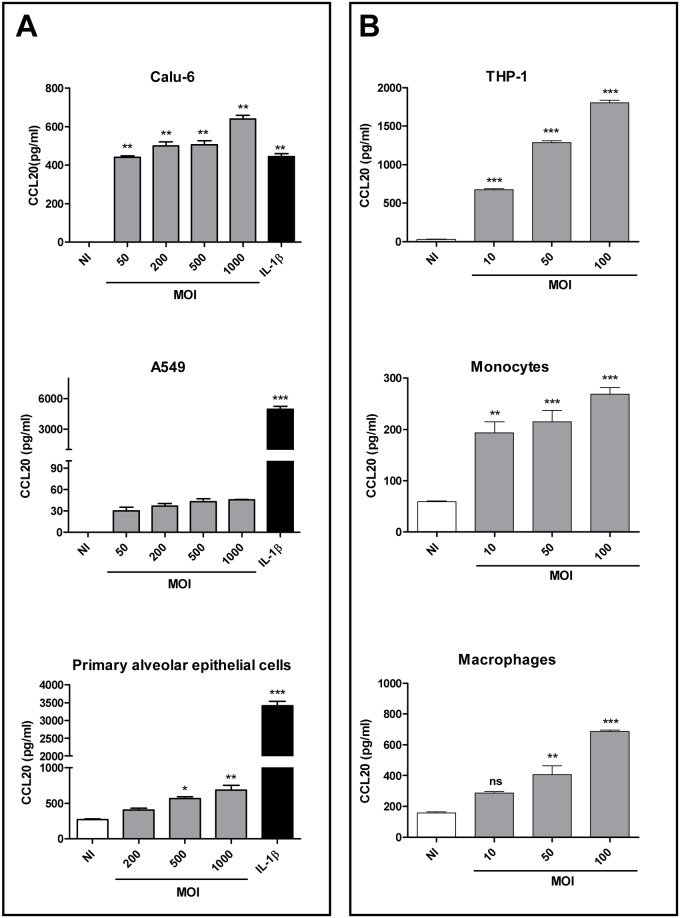

B. abortus induces CCL20 secretion by airways epithelial cells and human monocytes.(A) Calu-6 and A549 cell lines and primary alveolar epithelial cells were infected with B. abortus at MOIs 50 to 1,000 or were exposed to IL-1 β (1ng/ml) or media alone. (B) THP-1 cells, human peripheral blood-derived monocytes and monocyte derived-macrophages were infected with B. abortus at MOIs 10 to 100 or left untreated. Cell culture supernatants were harvested at 48 h, and CCL20 levels were measured by ELISA. Results are the mean ± SEM of three independent experiments. *, p<0.05; **, p<0.01; ***, p<0.001; and ns, non-significant difference versus non-infected cells (NI) (ANOVA followed by Dunnett’s test).